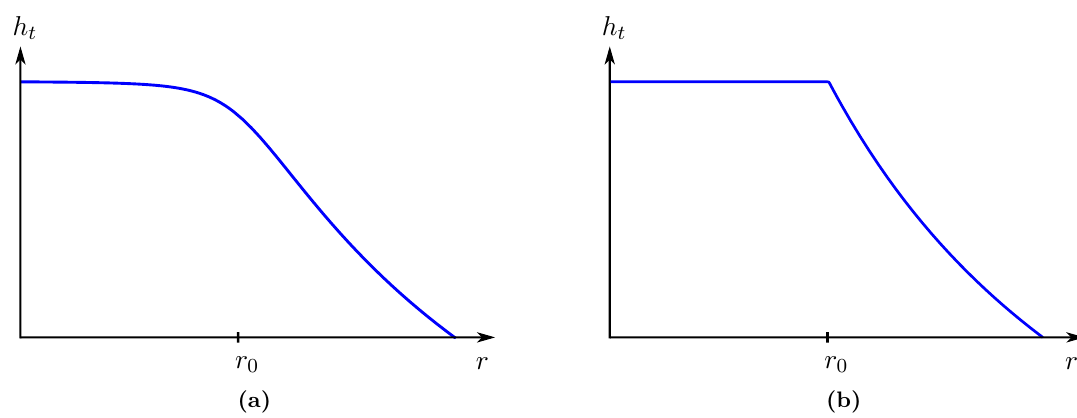
Figure 2. Gravitational potential below the brane as a function the coordinate distance r . This approaches a constant at small r and falls off as 1 /k − r at large r , with a transition around r = r 0 . The width of the transition is proportional to 1 /k 2 z . This can be seen in the figures above where (b) − is plotted for larger values of k − as compared to (a), for a fixed value of z , e.g., z = 2 , r 0 = 1 , k − = 5 for (a) and k − = 15 for